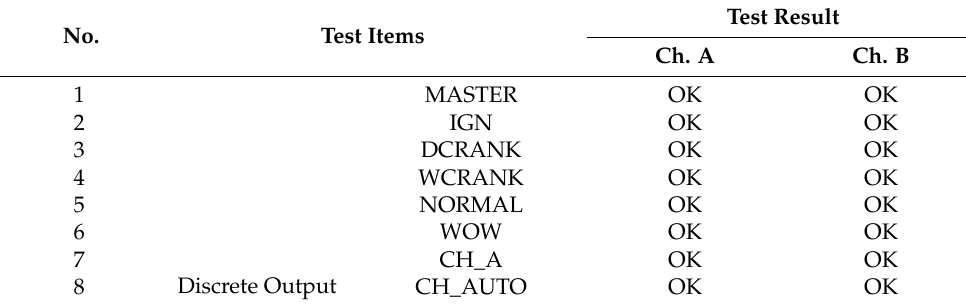
Table 4. Result of test bench functional